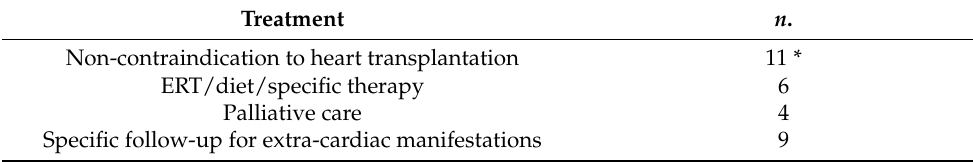
Table 3. Contribution to clinical management of urgent trio-WES results (number of infants).